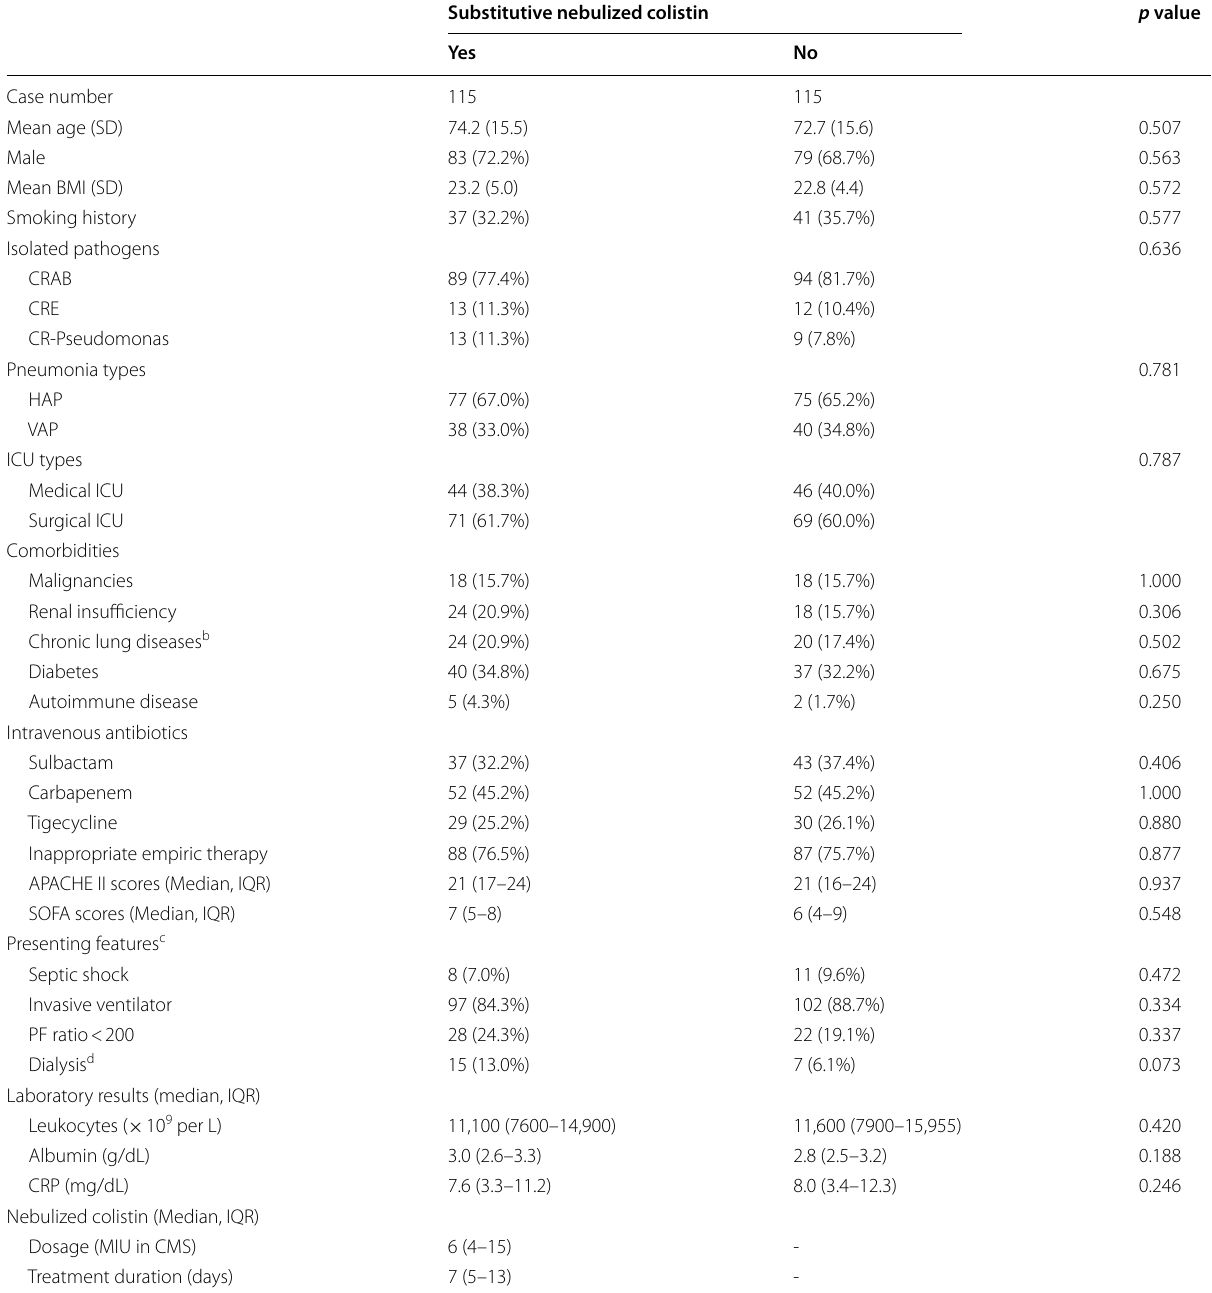
Table 2 Demographic characteristics and disease severities of PS‑matched ICU patients with nosocomial pneumonia treated with and without nebulized colistin in substitutive strategy